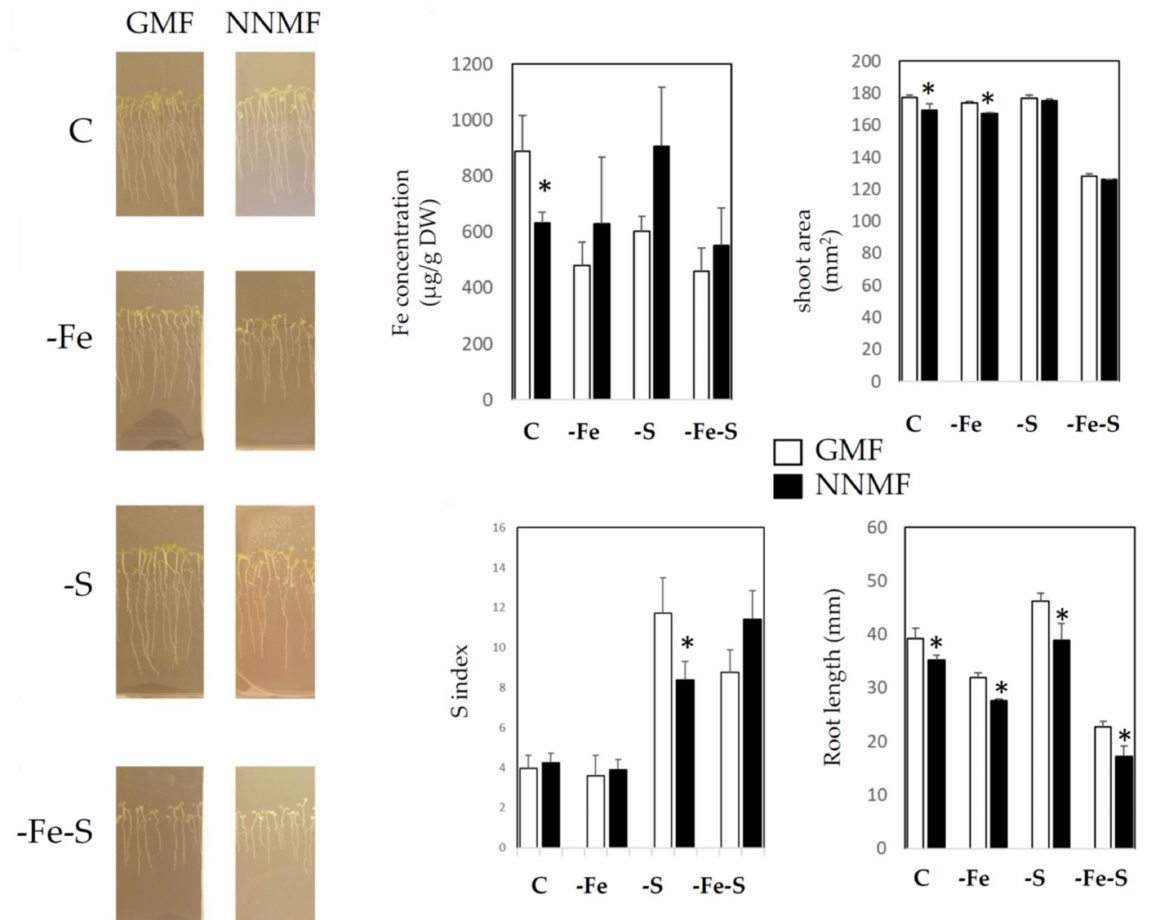
Figure 1. Morphometric measurements (root length and shoot area), Fe concentration, and S index of Arabidopsis thaliana seedlings grown under full nutrient conditions (C), absence of iron (-Fe), absence of sulfur (-S) and combined Fe and S deficiency (-Fe-S). Root length and shoot area measurements were performed 7 days after transferring seedlings from GMF to NNMF conditions. Mean values ( ± SE) are from 3 independent biological experiments and asterisks indicate significant ( p < 0.05) differences between NNMF and GMF exposed plants. Two-way ANOVA results are reported in Table